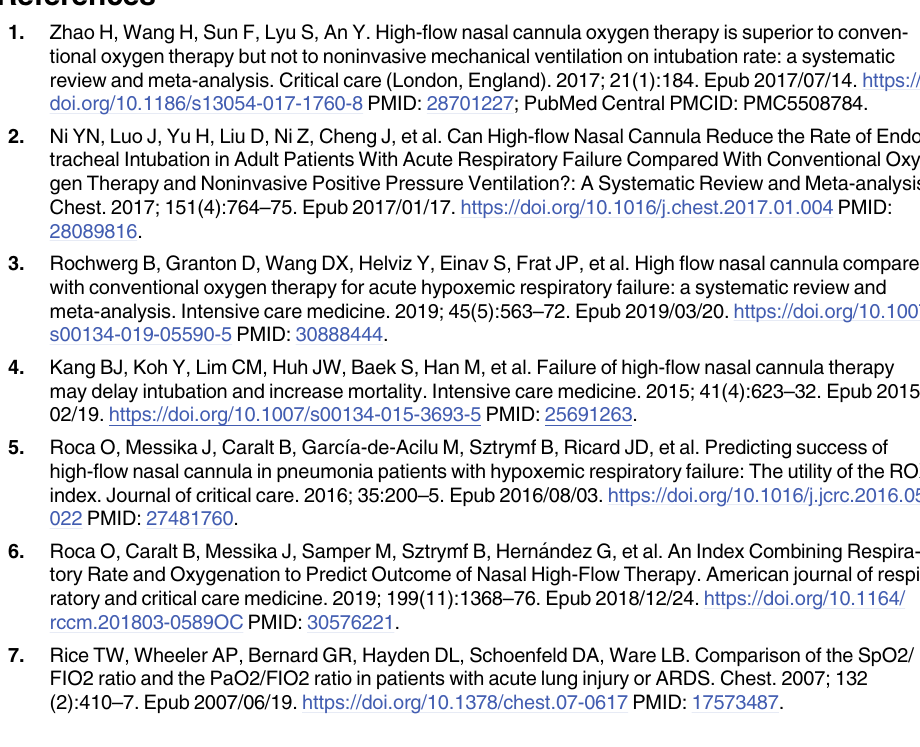
/FiO ratio for HFNC 2 2